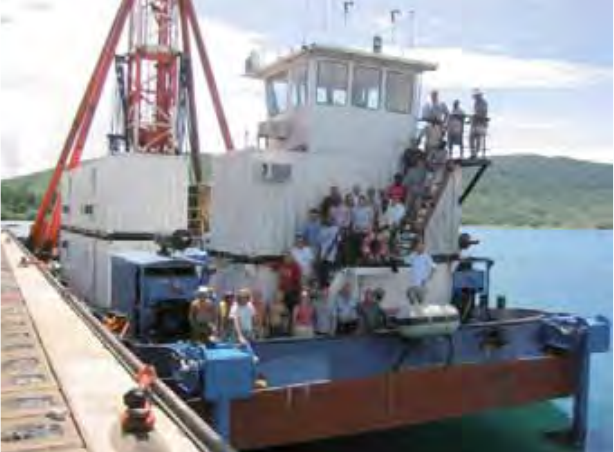
Figure 4. The drilling project